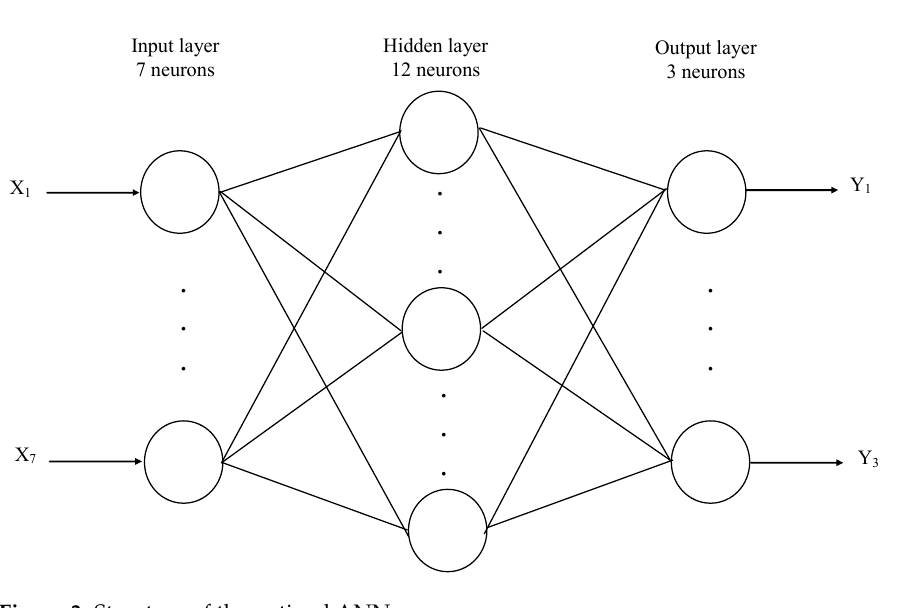
Figure 3. Structure of the optimal ANN.